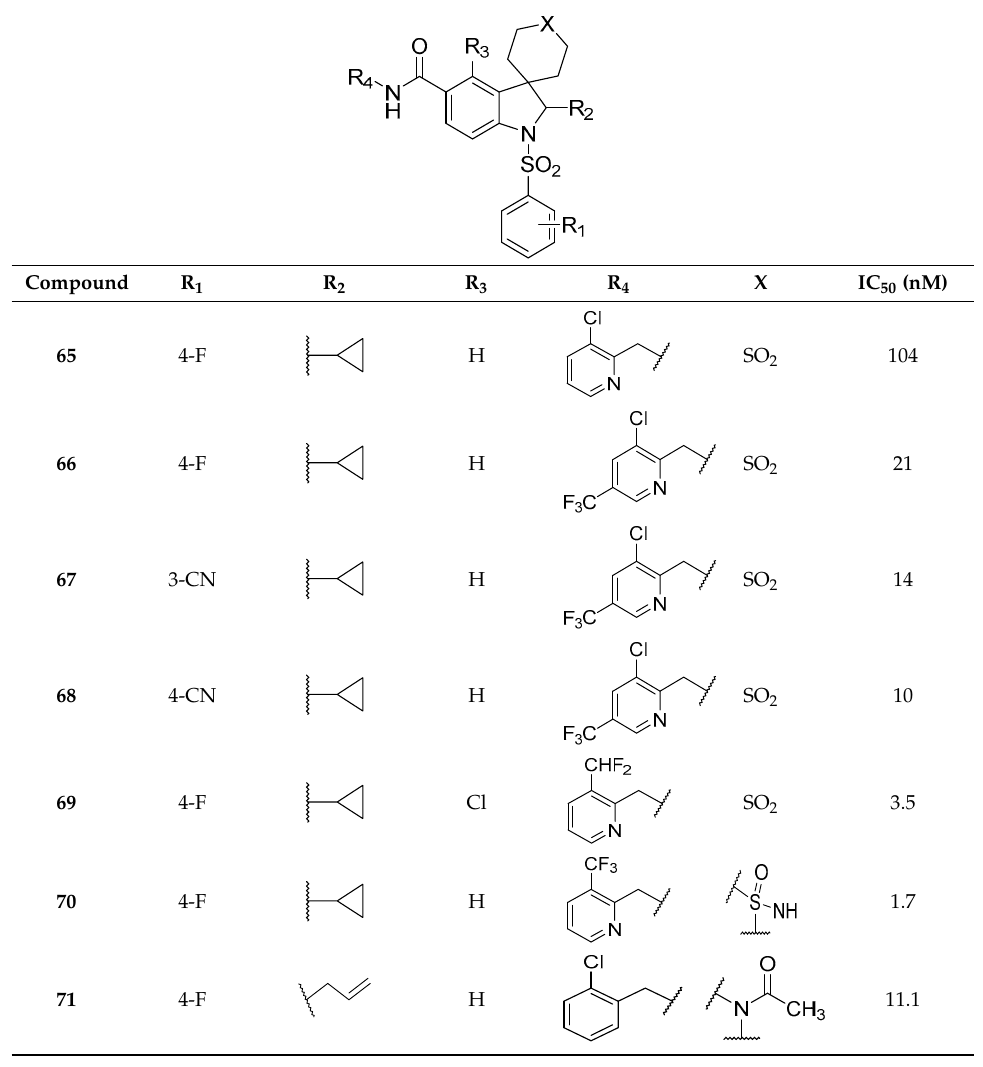
Molecules 2017 , 22 , 2188 Table 12. Spiroindoline derivatives and their binding affinity at human GnRH-R.